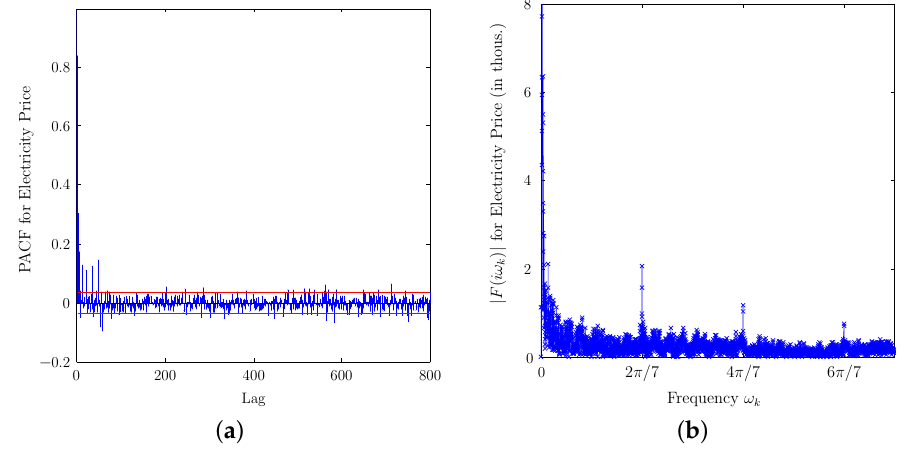
Figure 2. Analysis of partial correlations and periodogram for electricity prices. Source: Author’s cal-